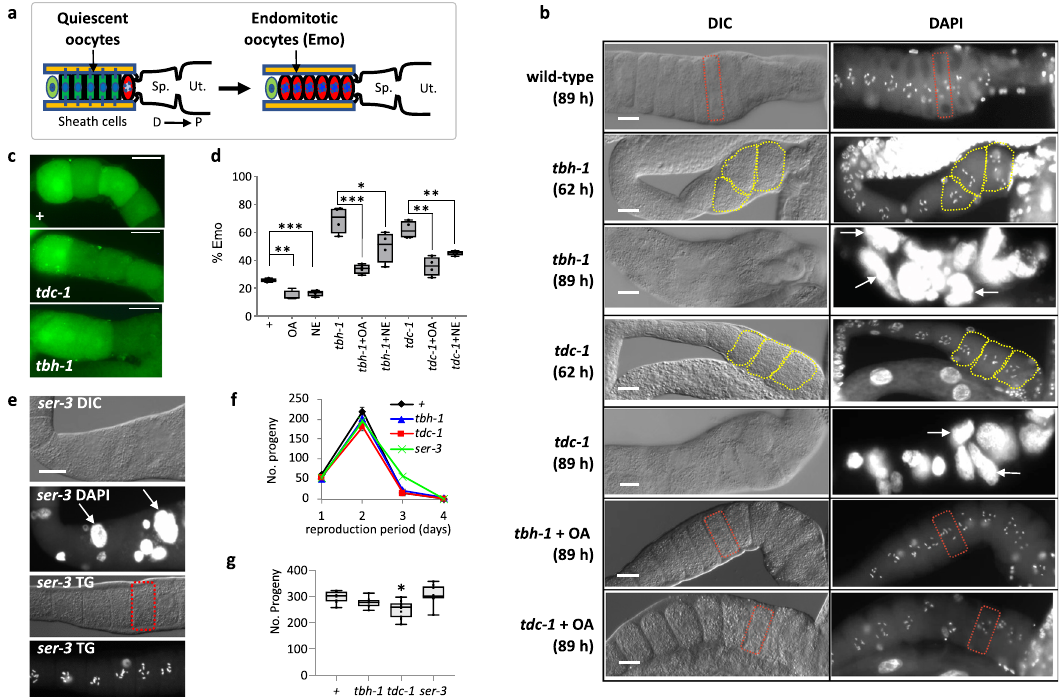
Fig. 2 Maintenance of quiescent oocytes by octopamine in C. elegans . a Progress to Emo after sperm depletion (quiescent oocytes in green, Emo in red, the gap junctions between oocytes and sheath cells in blue). D: distal, P: proximal, Sp.: Spermatheca, Ut.: Uterus. b Representative images of DIC (left) and DAPI staining (right) of oocytes (rectangles: quiescent oocytes, polygons: oocytes, arrows: Emo). The images represent 84 gonad images of wild-type, 9 gonads of 62 h of tbh-1 , 5 gonads of tdc-1 , 94 gonads of 89 h of tbh-1 , 77 gonads of tdc-1 , 66 gonads of tbh-1 + OA, 66 gonads of tdc-1 + OA. c Representative images of antibody staining of activated MAPK in the proximal oocytes 42 . Staining frequency: 77% for wild-type ( n = 35 gonads), 65% for tdc-1 ( n = 17 gonads), and 70% for tbh-1 ( n = 30 gonads). d Quanti fi cation of Emo at 89 h after hatch. Two-sided t -test: p = 0.001 (wild-type ( n = 113 animals) vs. wild-type + OA ( n = 99 animals)), 0.0003 (wild-type vs. wild-type + NE ( n = 109 animals)), 0.0004 ( tbh-1 ( n = 132 animals) vs. tbh-1 + OA ( n = 99 animals)), 0.035 ( tbh-1 vs. tbh-1 + NE ( n = 111 animals)), 0.001 ( tdc-1 ( n = 129 animals) vs. tdc-1 + OA ( n = 103 animals)), 0.002 ( tdc-1 vs.